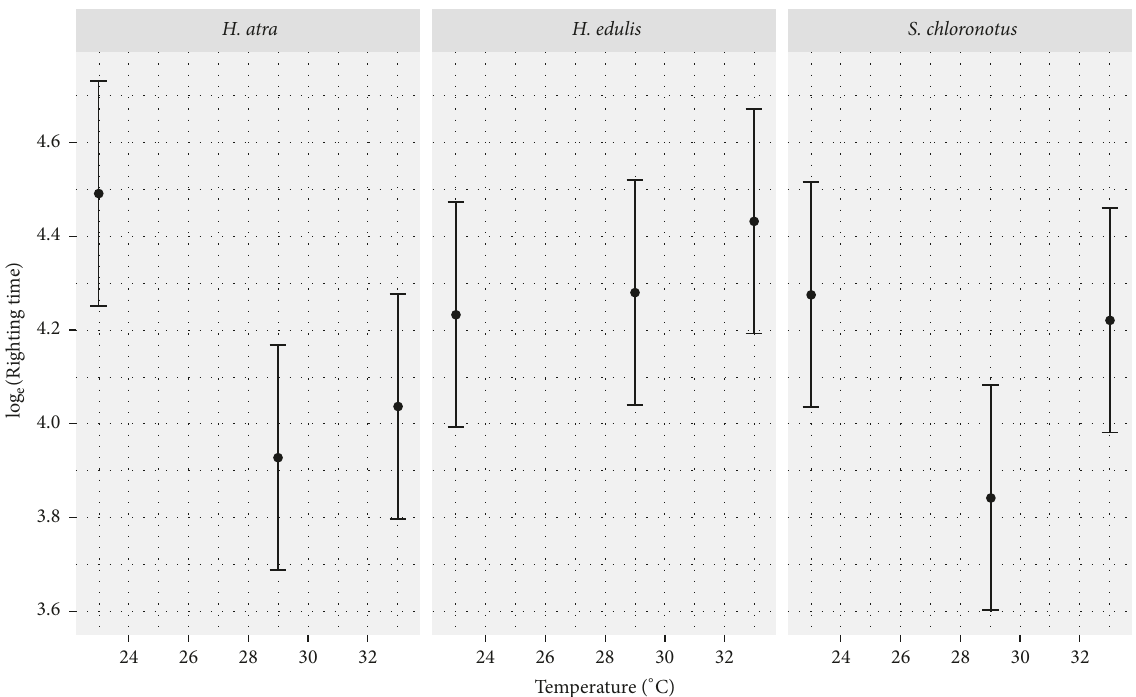
Figure 1: Effects of temperature on log e -transformed righting time within 95% confidence limits on the three sea cucumber species as estimated by the linear mixed model (see Table 2 for model